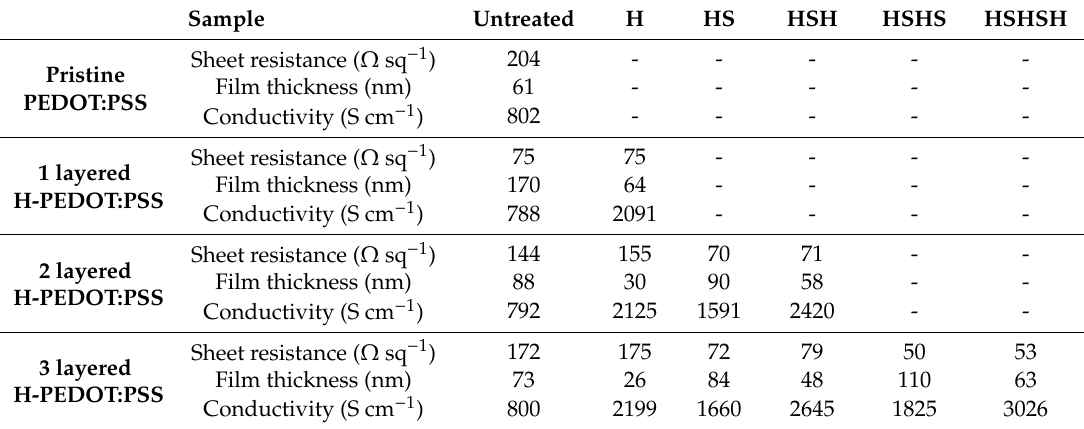
Table 1. The detailed sheet resistance, film thickness, and electrical conductivity data of PEDOT:PSS thin films according to H 2 SO 4 / DMSO post-treatment and LBL process.